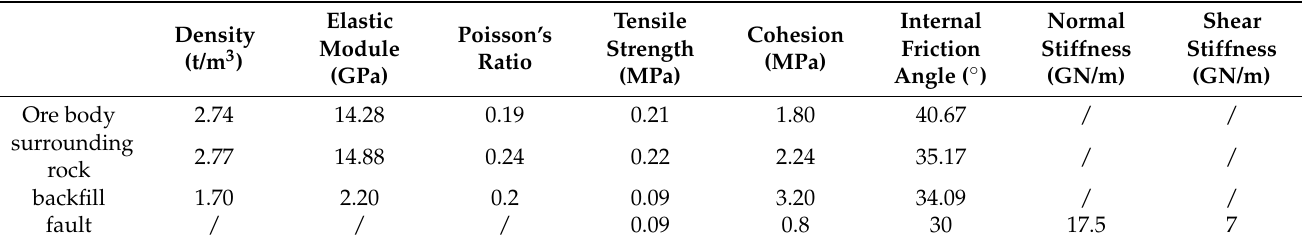
Figure 12. Monitoring positions and comparison of vertical displacements between monitoring and simulation after calibrations ( a ) Monitoring positions; ( b ) Comparison between monitoring and simulation. Table 2. Mechanical properties after